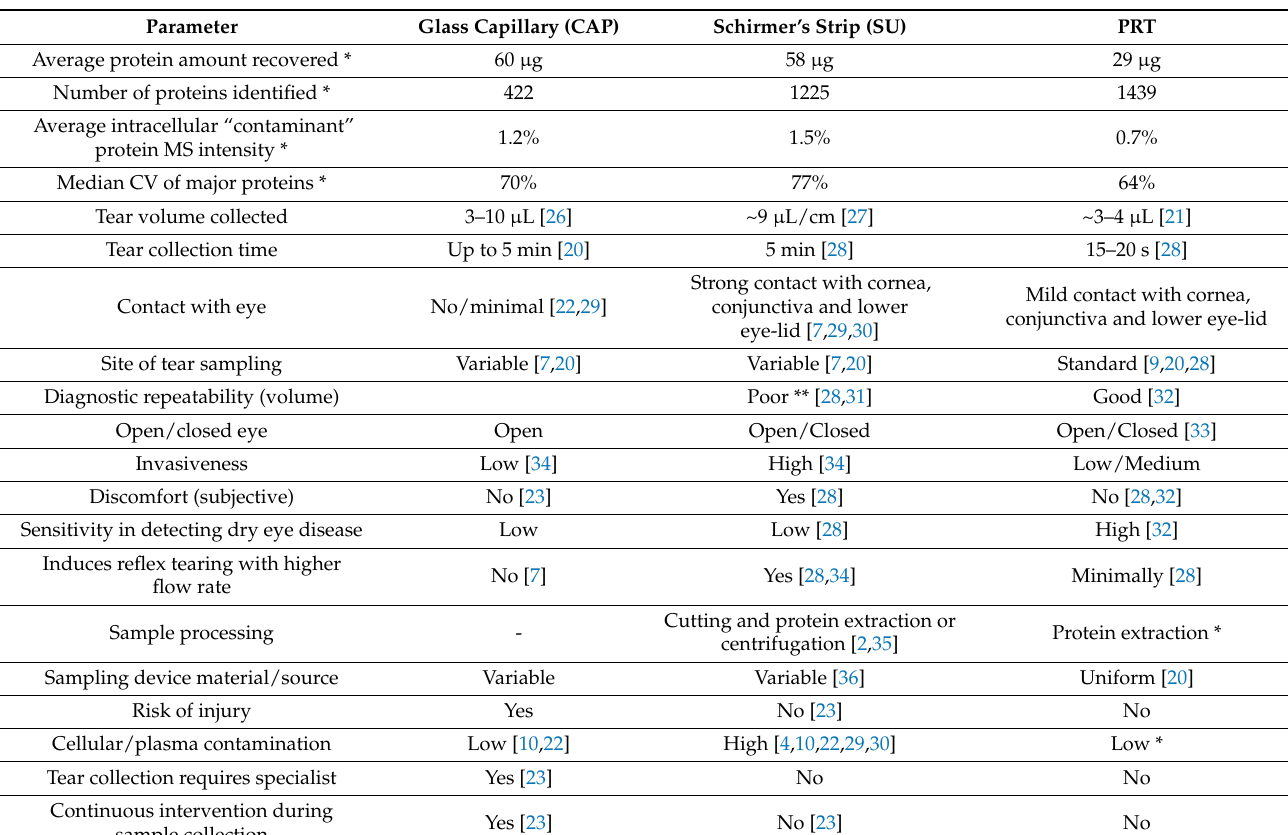
Table 2. Characteristics of tear collection methods for proteomics